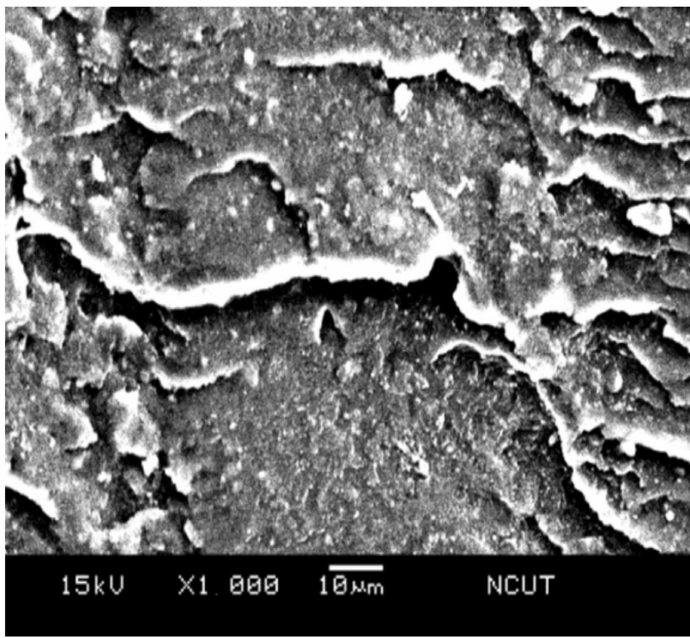
Figure 16. SEM micrograph of the fractured surface on PSA10 sample. With the simple addition of 5 wt.% TPE in the matrix, most of the radial tearing wrinkles disappeared, and a larger portion of flat area emerged on the surface, as seen in Figure 17. Both polystyrene and TPE mixed uniformly, and the hard and brittle property of the polystyrene changed. With further doping of 3 wt.% of alumina particles, i.e., PSTA3 sample, Figure 18 shows the fractograph having randomly oriented cracks, flake segments, and particulate/void structure. The rougher surface morphology denotes the sample can absorb more impact energy.